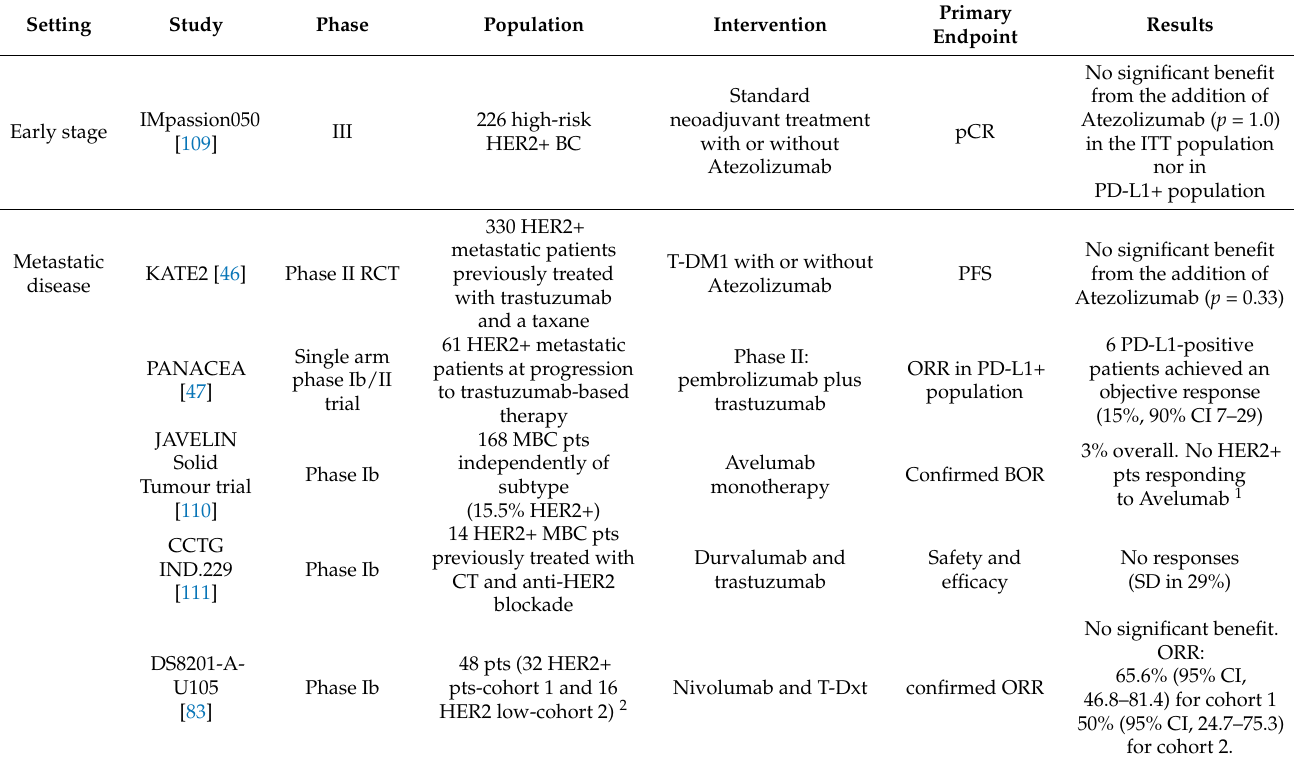
Table 2. Published trials with immune-checkpoint inhibitors in HER2+ breast